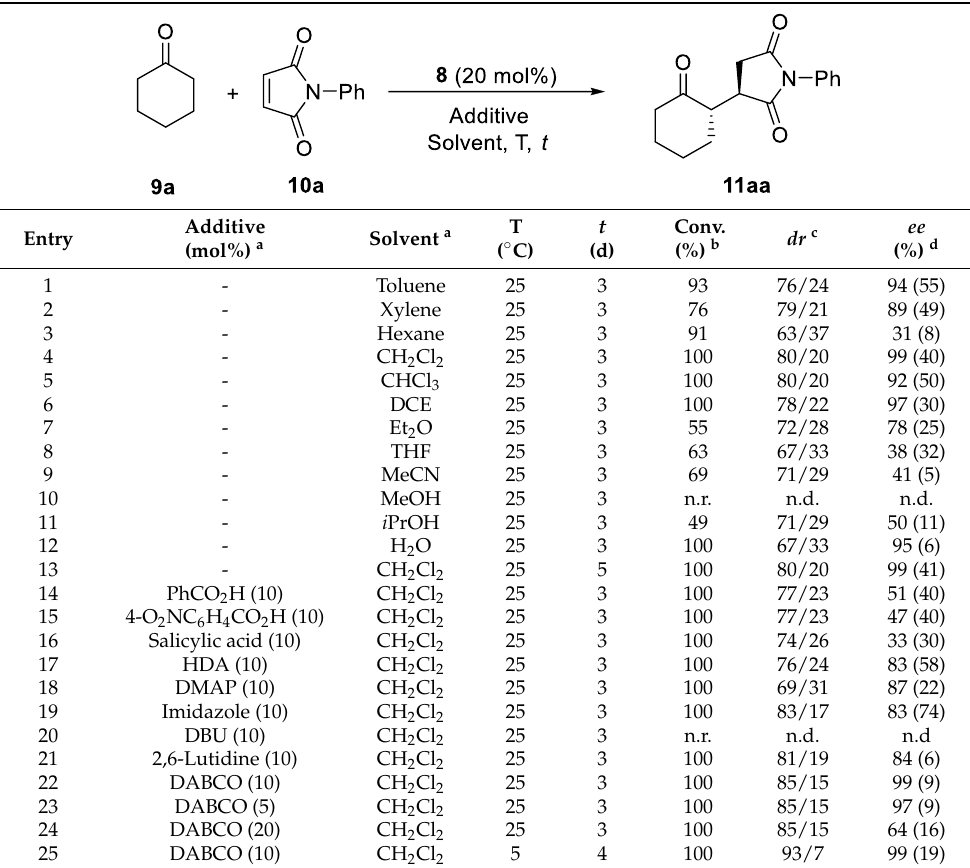
Table 1. Organocatalytic conjugate addition of cyclohexanone to N -phenylmaleimide. Optimization of the reaction conditions.